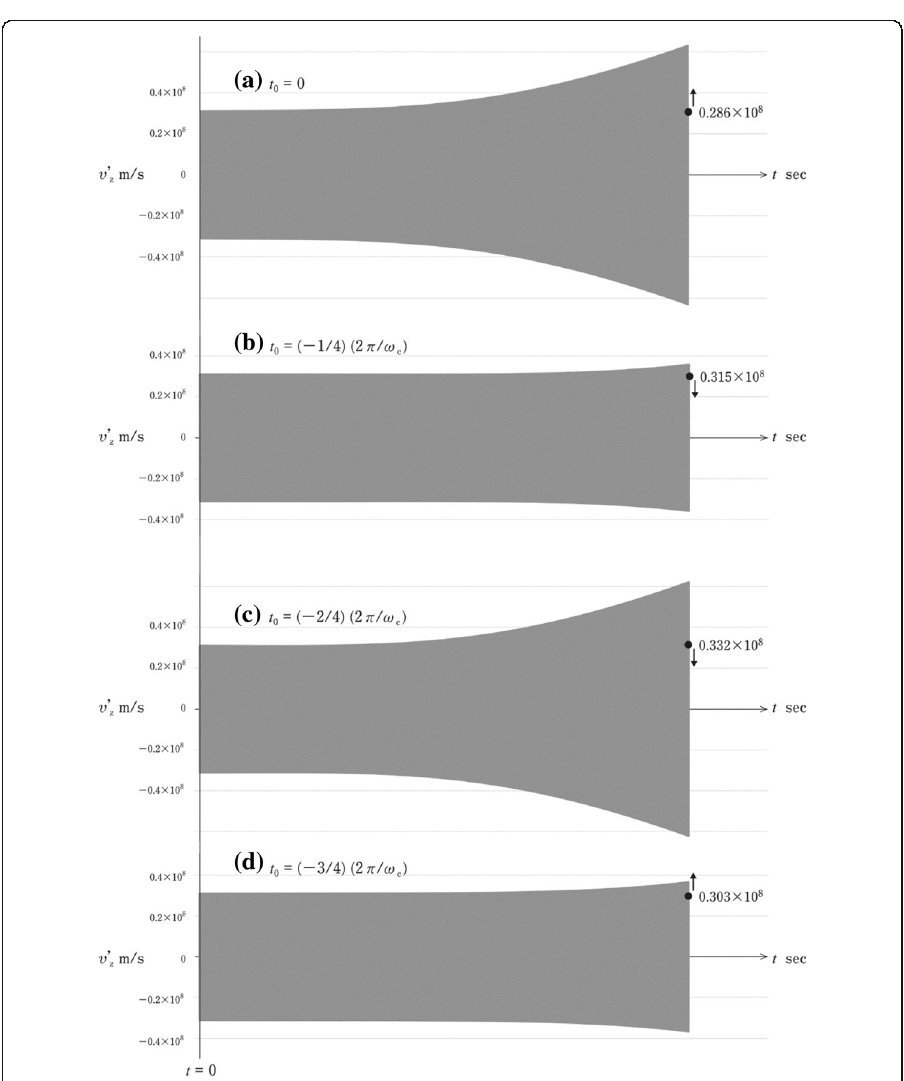
Fig. 8 a-d Dependence of a velocity υ ′ z of a relativistic electron on the phase of an electric field, based on Eq. (12). The figures are drawn under the same physical conditions with for Eq. (27): an initial velocity ¼ j ^ z ð − 0 : 31 (cid:2) 10 8 Þj m/s at time t z 0 (cid:2) 10 11 j sec − 1 , ω c / ω =1.0001. The flight time t = t dots mark the last velocity points after the